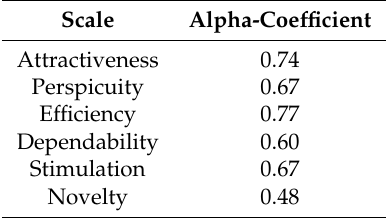
Figure 10. MIRA user experience questionnaire aggregated score of pragmatic and hedonic qualities. Table 5. Correlation of items per scale using Cronbach’s Alpha